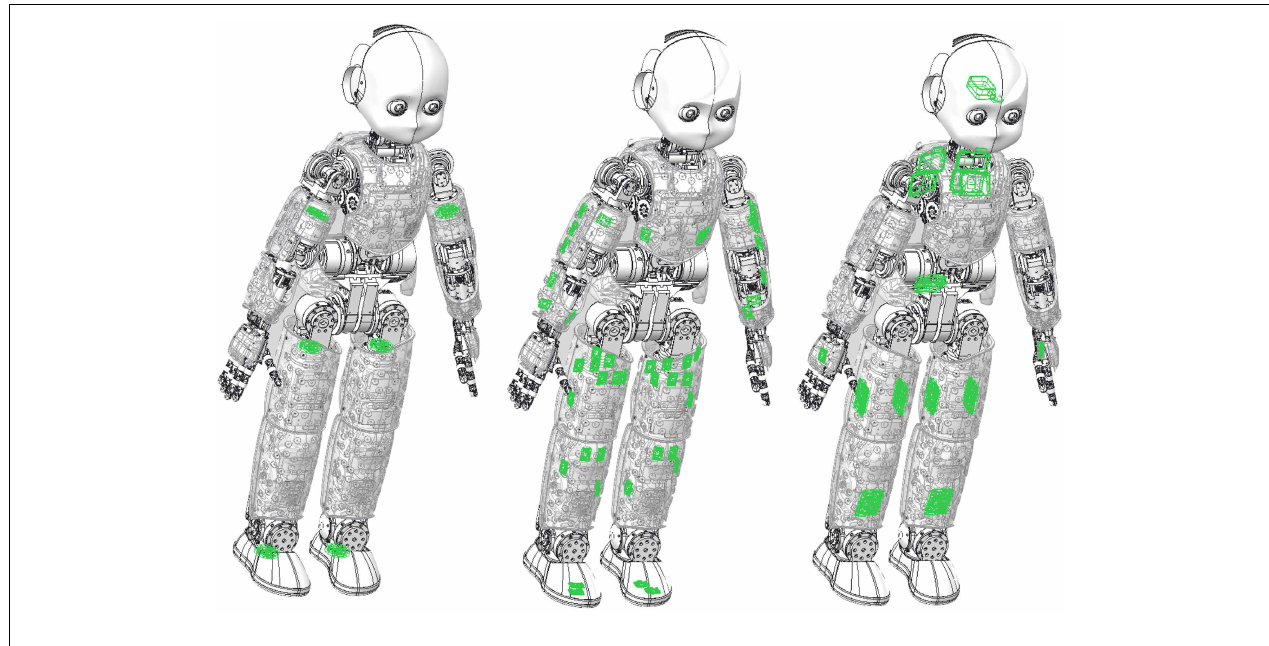
microcontrollers, which have a 3D accelerometer embedded. Right : locations of the motor microcontrollers and the commercial inertial sensor, with the latter having a 3D gyroscope and a 3D accelerometer embedded.